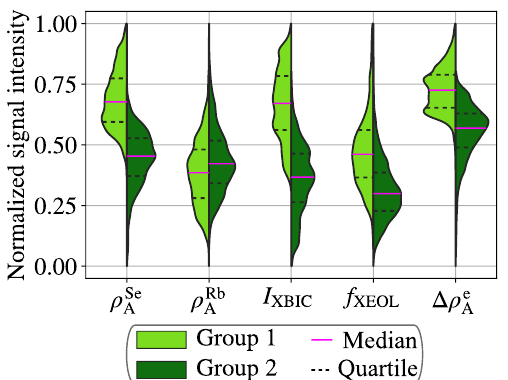
Figure 5. Violin plots of the 5 key measurands, split by the groups of the k -means clustering. The signal intensity is scaled such that 0 and 1 correspond to the minima and maxima of the maps shown in Figure 4 for the area density of Se ( ρ Se ) and of Rb ( ρ Rb ), of the XBIC ( I XBIC ), of the XEOL A A photon count rate ( f XEOL ), and of the relative electron area density ( ∆ ρ e ). The distributions, scaled to A the same area, are normalized such that their amplitude (shown on the horizontal axis) is proportional to the area with the corresponding measurement value for each group. Magenta lines indicate the median values, and dashed lines indicate the 25th and 75th